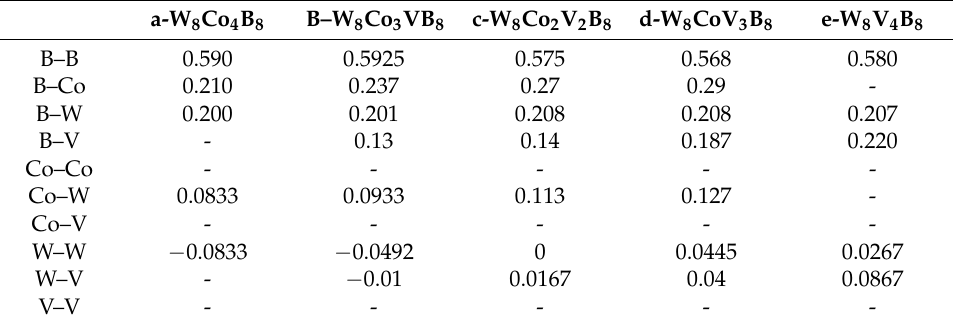
Table 5. Calculated overlap population of bonds for W 8 Co 4 − x V x B 8